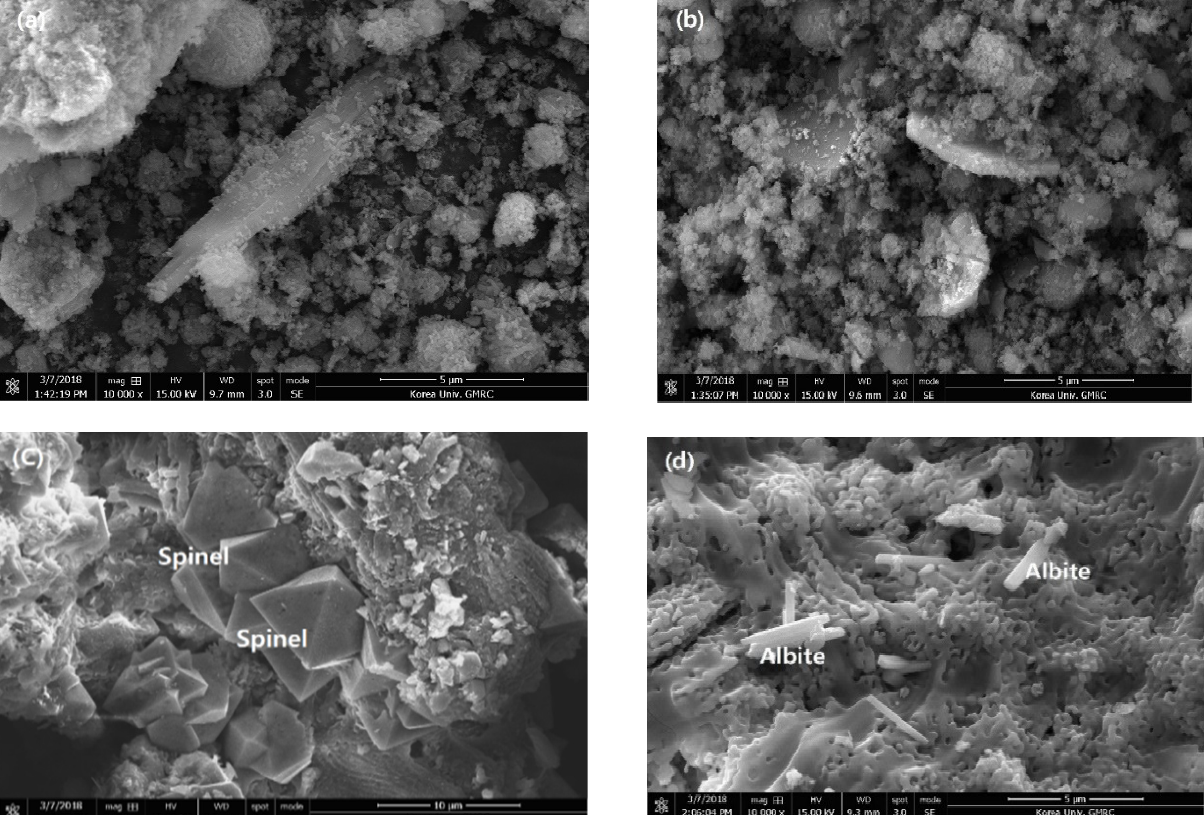
Figure 6. SEM images of the red mud heated with microwaves: ( a , b ) are the red mud slurry heated with microwaves for 5 min and 15 min at 5000 W; ( c , d ) are the red mud-solidNH 4 Cl heated with microwaves for 10 min and 15 min at 5000 W.